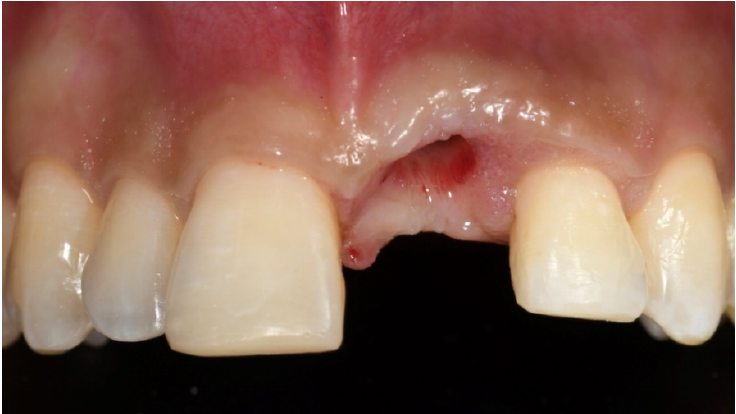
Figure 12. Five months after implant placement, management of soft tissue with screw- retained temporary restoration.